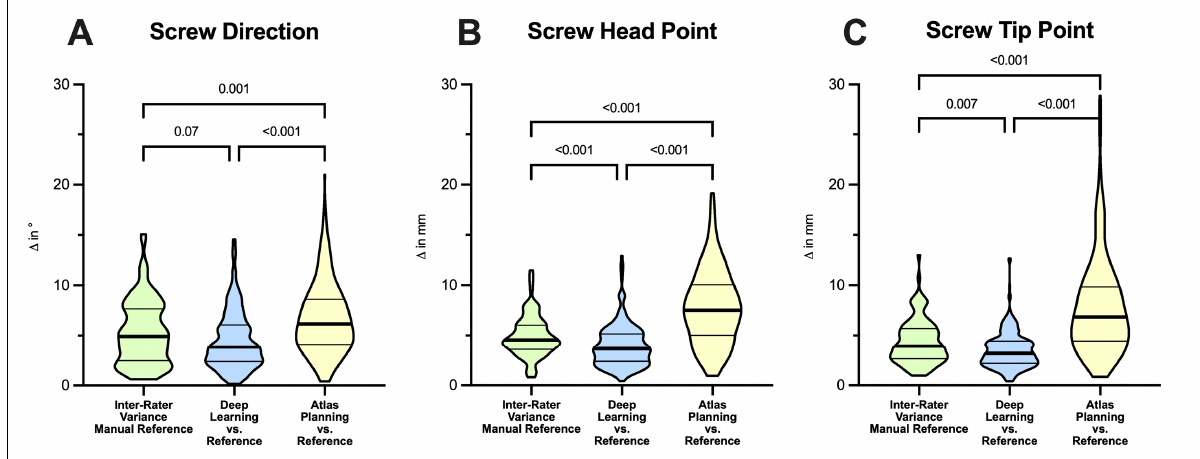
Figure 1. Comparison of screw planning results using screw direction ( A ), screw head ( B ) and screw tip points ( C ) as benchmarks. Violin plots illustrate mean absolute di ff erences for deep-learning- and atlas-based planning tools with their respective manually planned reference screws. Interrater variance of manual screw planning puts automatic planning performance into clinical context of current standards in navigated spine instrumentation. Note the reduced success in atlas-based planning (208/256 screws, 81%) available for analysis. Statistical signi fi cance was tested with Kruskal–Wallis tests followed by Dunn’s post-test for multiple comparisons.